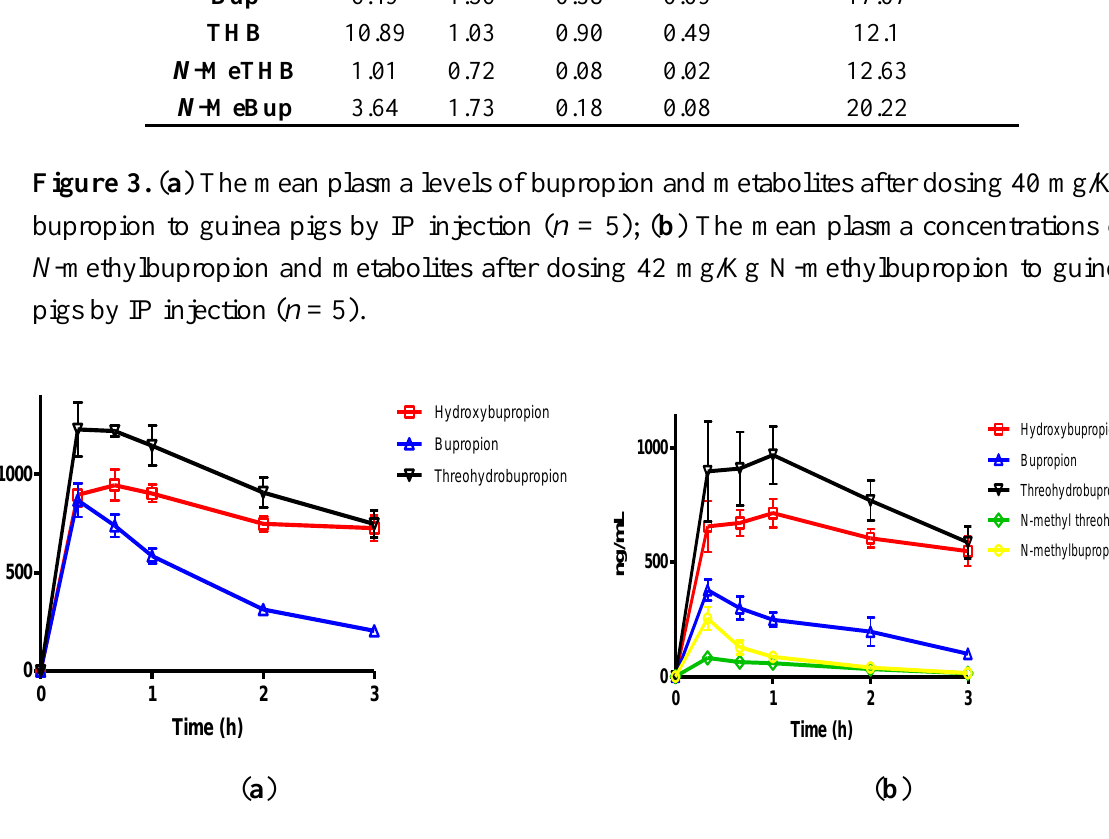
Figure 4. ( a ) The mean brain concentrations of bupropion and metabolites 20 min after dosing 40 mg/Kg bupropion to guinea pig by IP injection ( n = 5); ( b ) The mean brain concentrations of N -methylbupropion and metabolites 20 min after dosing 42 mg/Kg N -methylbupropion to guinea pigs by IP injection ( n =